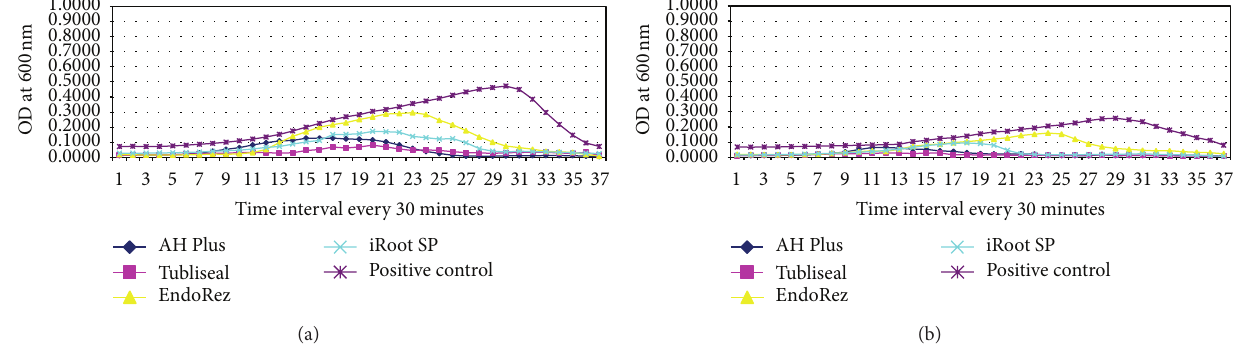
Figure 3: Line graph showing microbial growth curve of C. albicans in (a) presence of tested sealers, A well and (b) absence of tested sealers, B well of the four different endodontic sealers. 𝑥 -axis depicts time intervals at which the mean OD was recorded (at every 30 mins) and 𝑦 -axis depicts mean corrected OD recorded at 600 nm. Each point on the growth curve is the average of the OD measured in 12